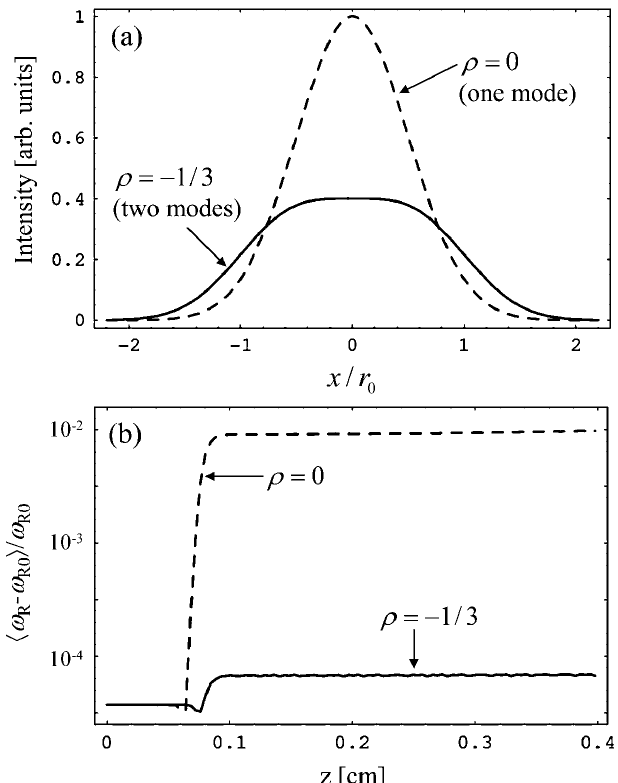
FIG. 6. Transverse gradients in the pump laser can be signifi- cantly reduced by the addition of higher-order Laguerre- Gaussian modes. (a) Intensity versus transverse position for a pump lasers with (cid:10) ¼ 0 (fundamental Gaussian) and (cid:10) ¼ (cid:4) 1 = 3 =a is the ratio of (two modes) with equal power, where (cid:10) ¼ a 1 0 mode amplitudes. The fundamental mode is characterized by ¼ 0 : 5 , r ¼ 400 (cid:1) m , (cid:2) ¼ 1 (cid:1) m , and Z ¼ 50 cm . a R 0 0 0 (b) Resonant frequency spread versus propagation distance for ¼ 12 : 5 , r ¼ 70 (cid:1) m , and beam an electron beam with (cid:6) b 0 ¼ 1 mm mrad interaction with a pump laser with emittance " n (cid:10) ¼ 0 and (cid:10) ¼ (cid:4) 1 = 3 . The inclusion of a higher-order mode reduces the resonant fractional frequency spread by more than 2 orders of magnitude, to (cid:1) 8 (cid:5) 10 (cid:4) 3 %